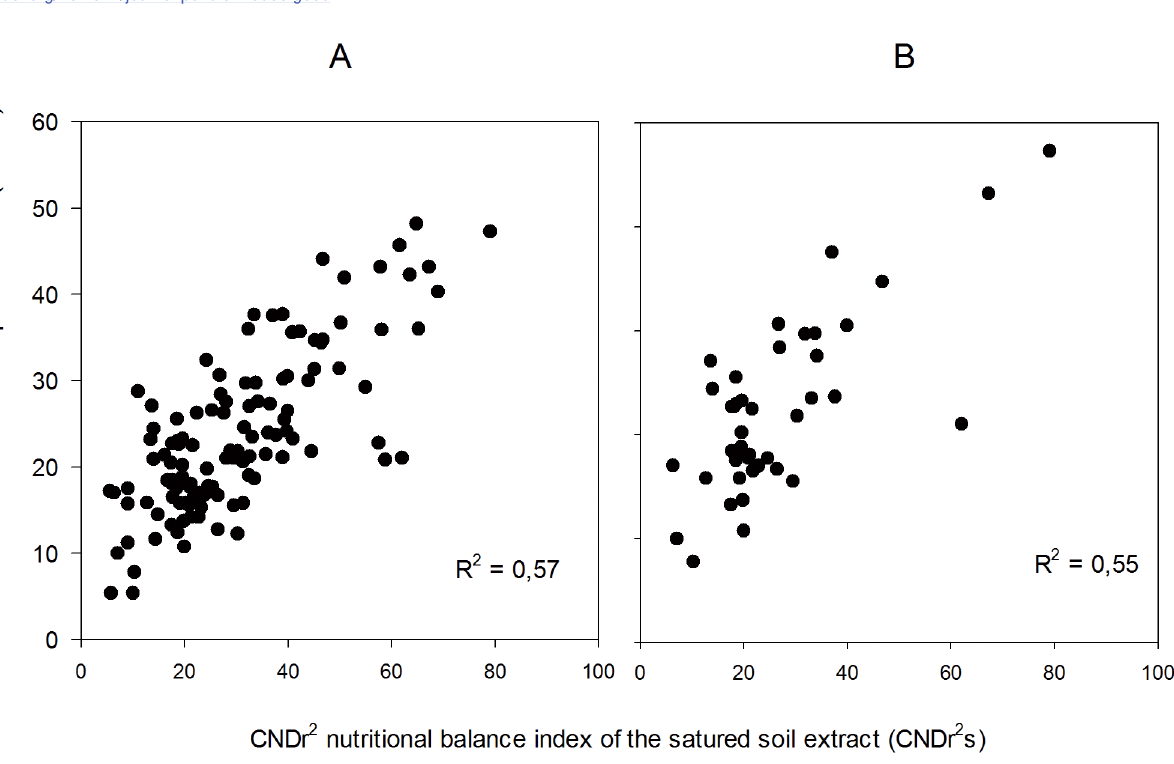
Fig 4. Correlations between CND f (plant tissue) and CND s (SSE) index. Electric Conductivity (EC) restriction. (A) EC range: 1.1 and 5.8 dS m -1 . p < 0.001n = 124. (B) EC range 1.8 and 2.5. p < 0.001n = 35. https://doi.org/10.1371/journal.pone.0178500.g004 PLOS ONE | https://doi.org/10.1371/journal.pone.0178500 May 25,